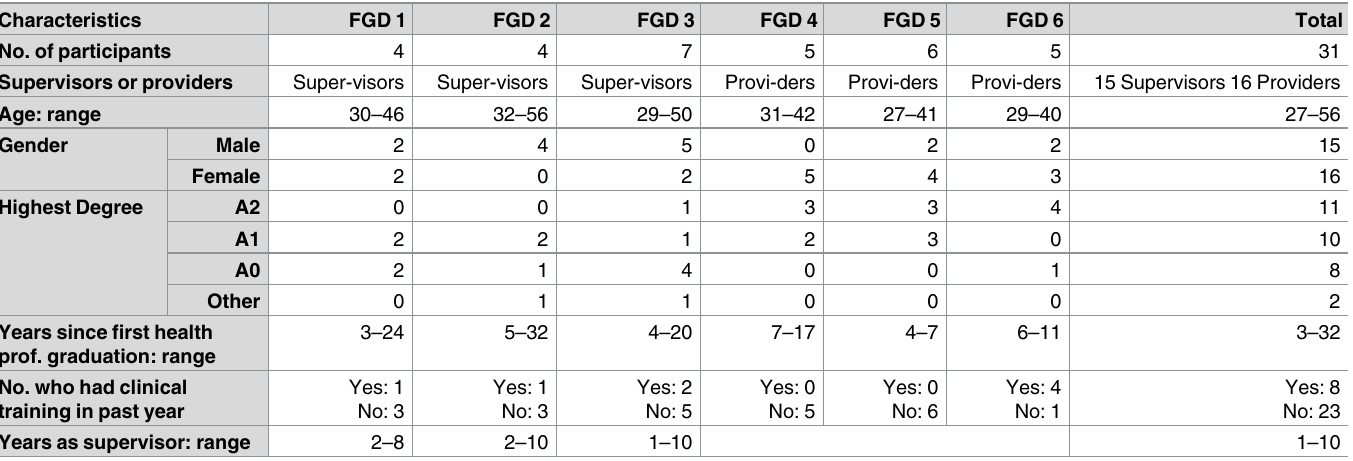
Table 1. Participant